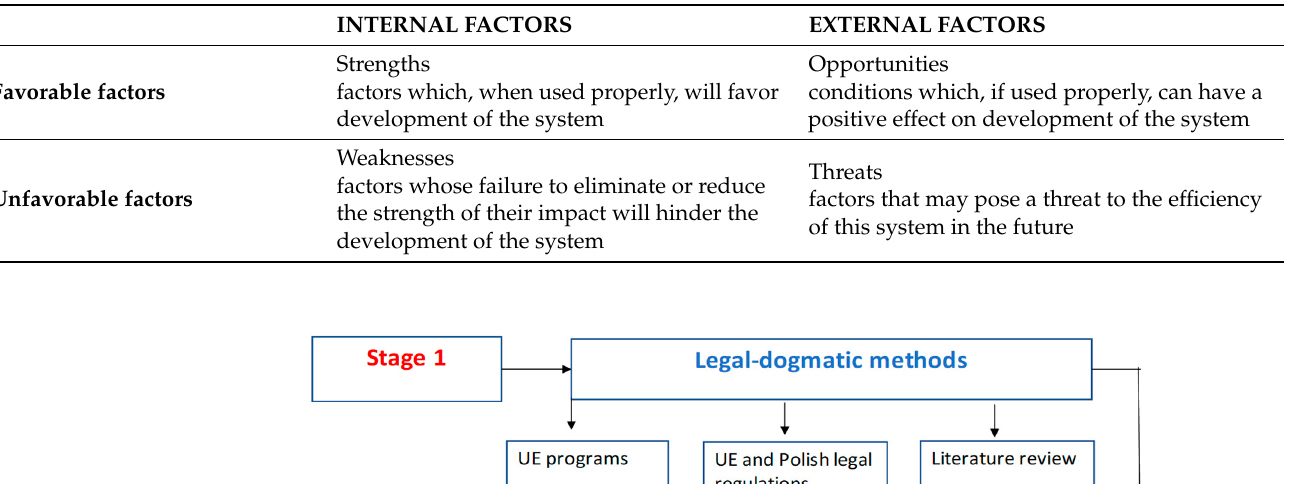
Table 2. Scheme for SWOT analysis of the industrial waste management system [36].